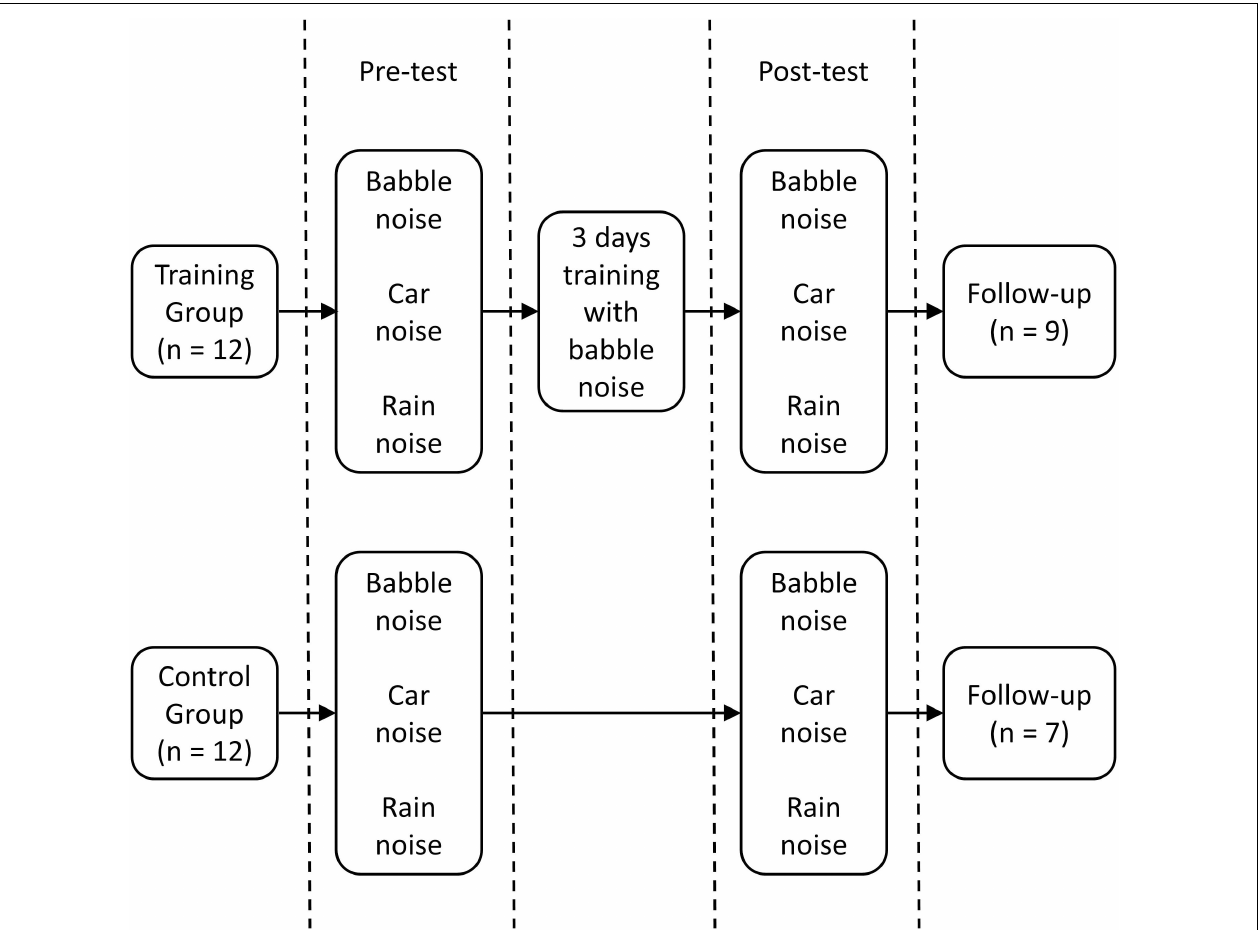
FIGURE 2 | Experimental